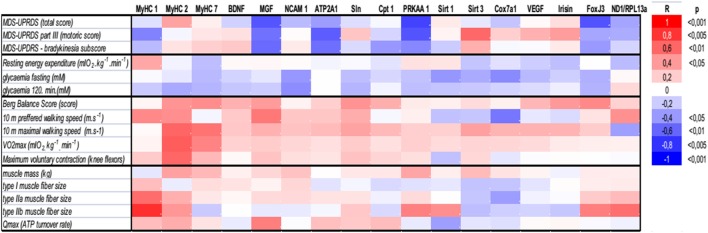
Associations of (i) clinical PD disability score (MDS-UPDRS), (ii) whole-body and muscle metabolism (resting energy expenditure, FPG, 2HG, Qmax), (iii) functional, and (vi) morphological characteristics with the expression of genes related to muscle functional phenotypes, energy metabolism, and mitochondrial biogenesis. ATP2A1, sarcoplasmic/endoplasmic reticulum calcium ATPase 1 isoform (Serca1); BDNF, brain-derived neurotrophic factor; Cpt 1, carnitine palmitoyltransferase 1; Cox7a1, cytochrome c oxidase polypeptide 7a1 isoform; FNDC5, fibronectin type III domain containing 5- precursor of Irisin; FoxJ3, forkhead box J3; MGF, mechano-growth factor—splice variant of the Insulin-Like Growth Factor-1 (IGF-1 Ec); MDS-UPDRS, Movement Disorder Society–Unified Parkinson’s Disease Rating Scale, MyHC, myosin heavy chain isoform; NCAM 1, neural cell adhesion molecule 1 isoform; ND1, NADH dehydrogenase subunit 1 was measured to determine the amount of mitochondrial DNA relative to the expression of genomic DNA for Rpl13a; PRKAA1, AMP-activated protein kinase alpha catalytic subunit 1 (AMPKα1); Qmax, dynamic muscle ATP flux; SLN, sarcolipin; Sirt, sirtuin; VEGF, vascular endothelial growth factor; VO2max, maximal aerobic capacity.